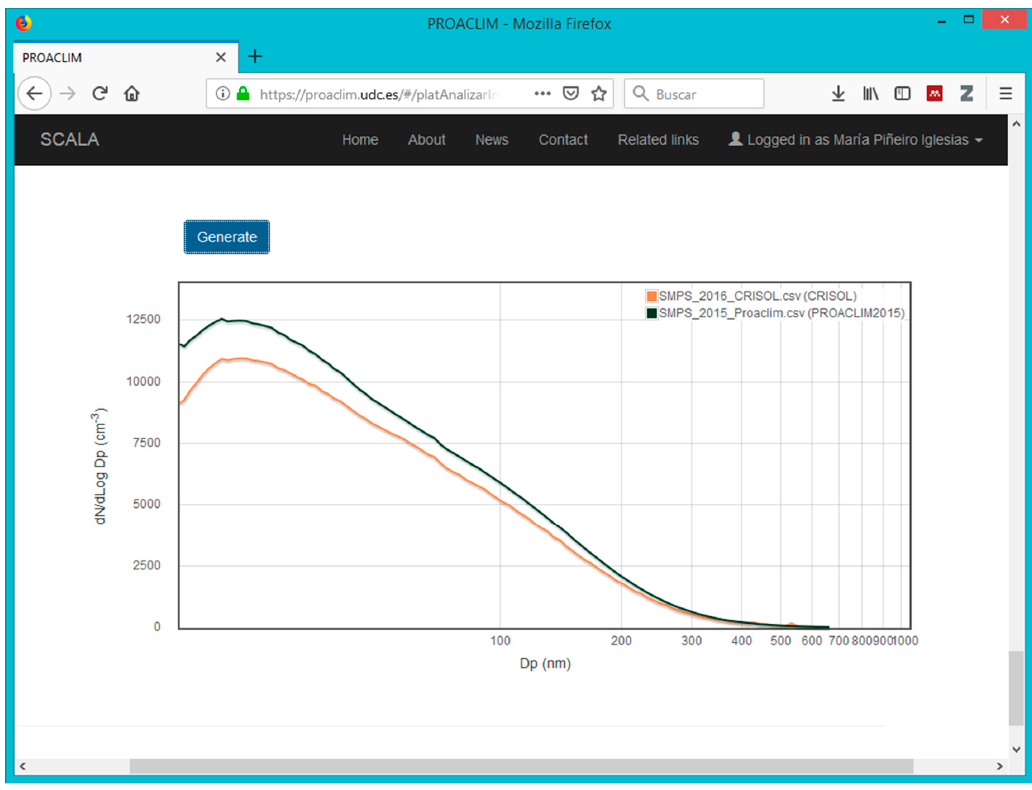
Figure 7. Average dN/dLog dp (cm − 3 ) vs. dp (nm) for the SMPS at CIEMAT site during campaigns PROACLIM and CRISOL (years 2015 and 2016).